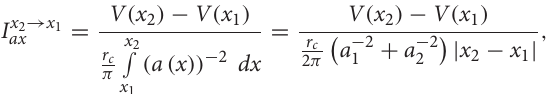
Frontiers in Neuroanatomy |